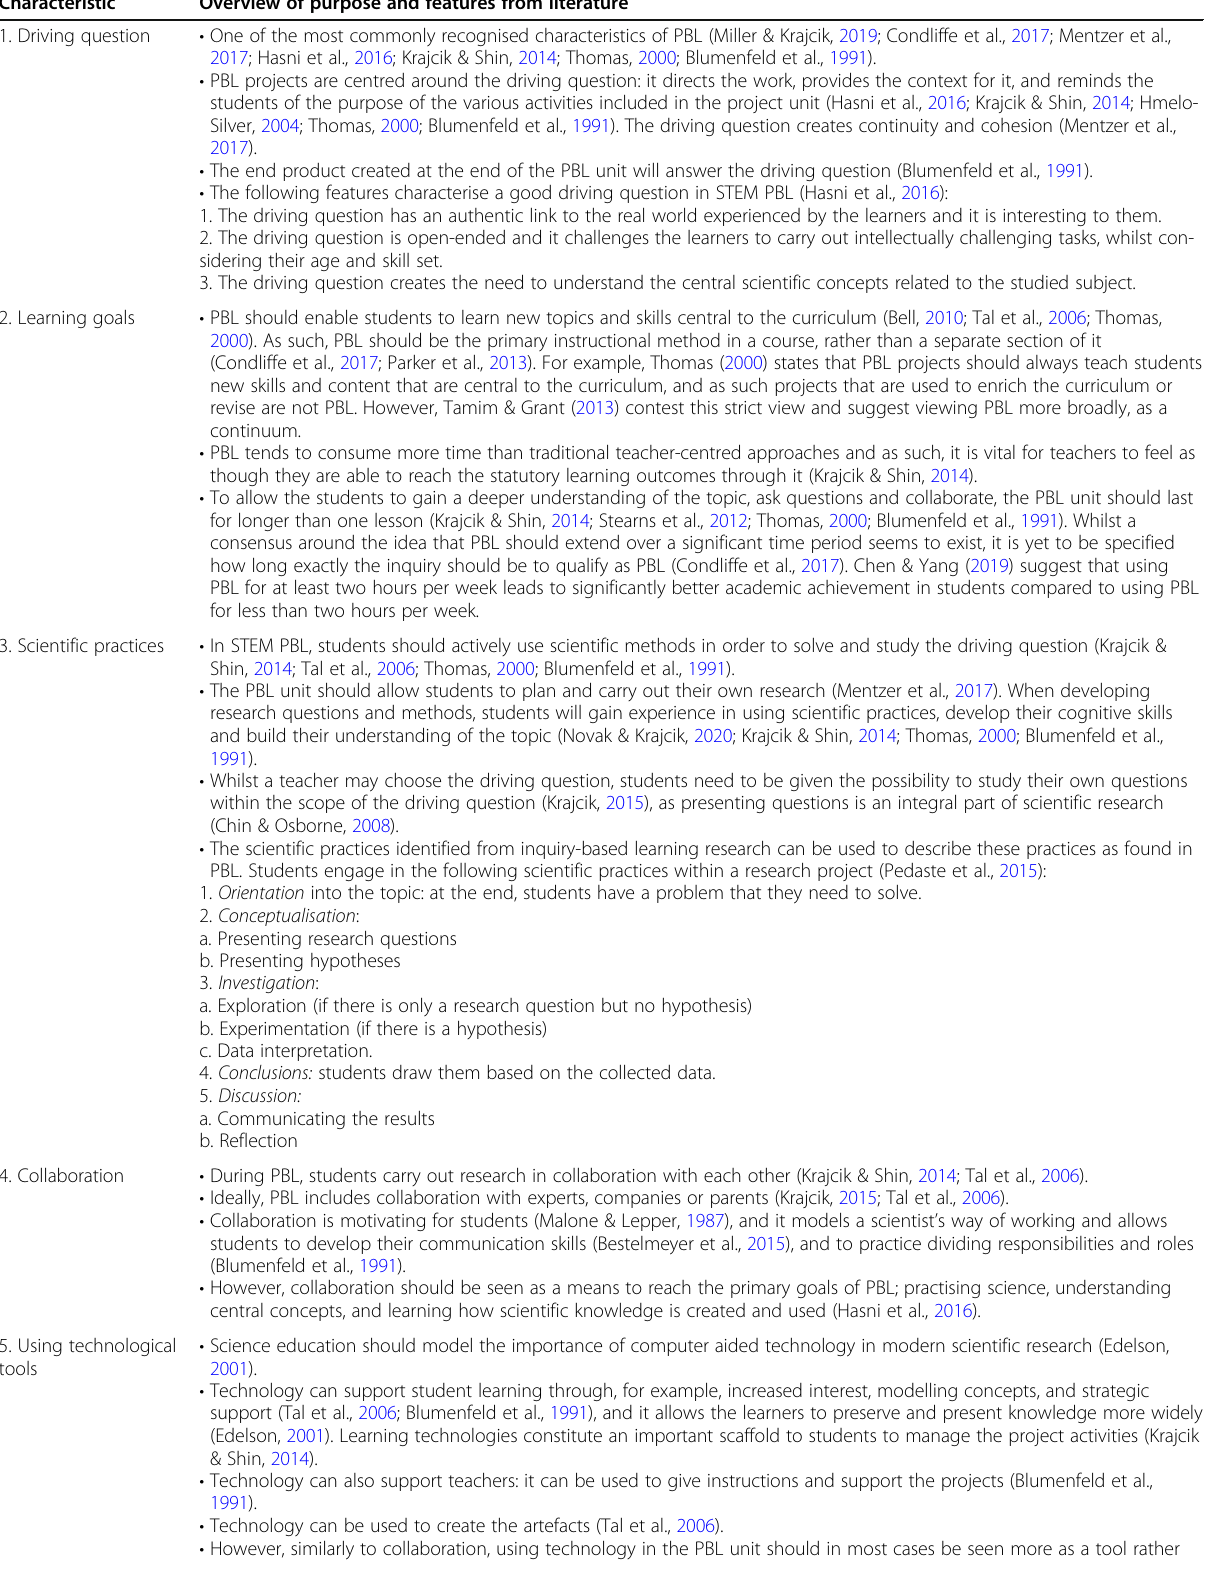
Table 1 Framework of the key characteristics of PBL. The six characteristics are as proposed by Krajcik & Shin (2014)